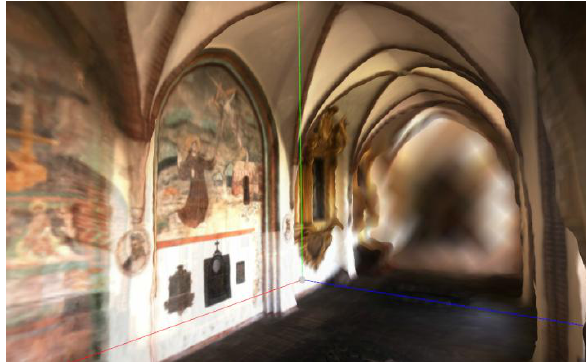
Figure 16. Flare3D viewer enables to have a 3D virtual tour through the object.